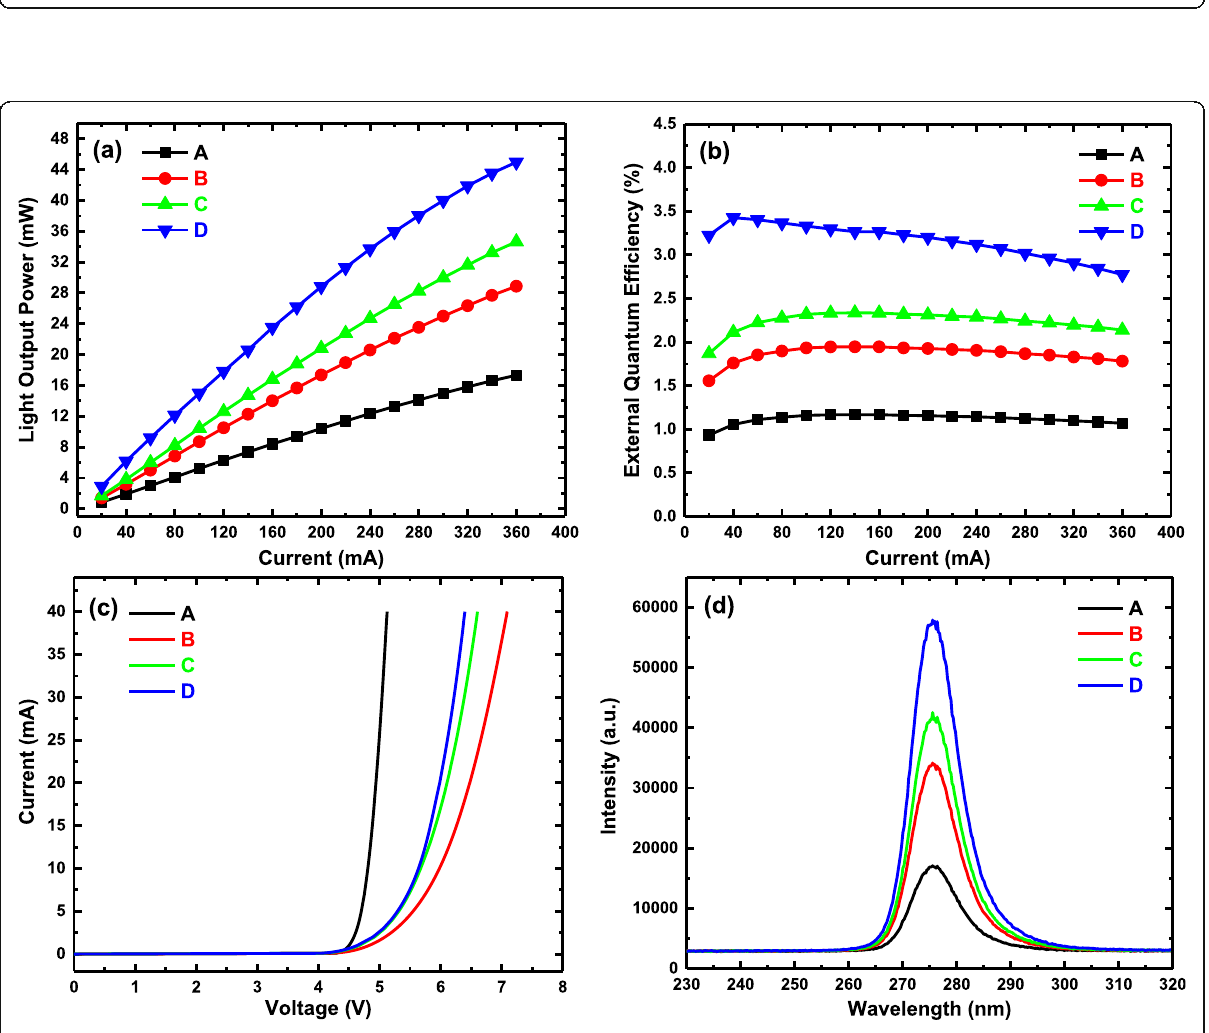
Fig. 3 Electrical and optical characteristics of samples with different SEDLs at room temperature. a Dependence of LOP on injection current under the CW biases. b Dependence of EQE on injection current under the CW biases. c Dependence of injection current on operation voltage. d EL spectra of all the samples at 10-mA injection current, the peak emissions of which are around 275